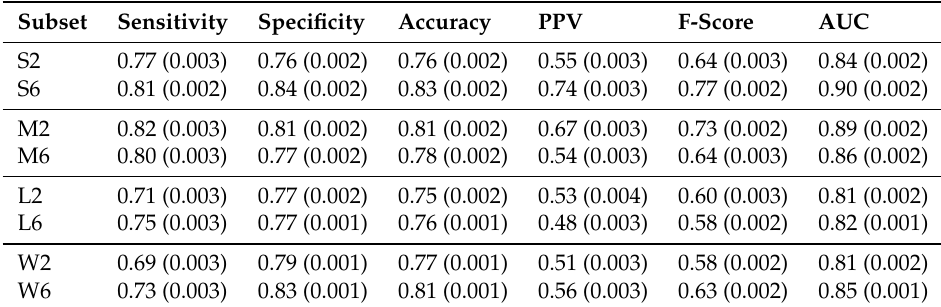
Table A6. Predictive performance of linear discriminant analysis based on the estimated sensitivity, specificity, accuracy, positive predictive value (PPV), F-score and the area under receiver operating characteristic curve (AUC) for two-week and six-week restriction period among the cows in early (S), mid (M) and late (L) lactation stage using cross validation studies.